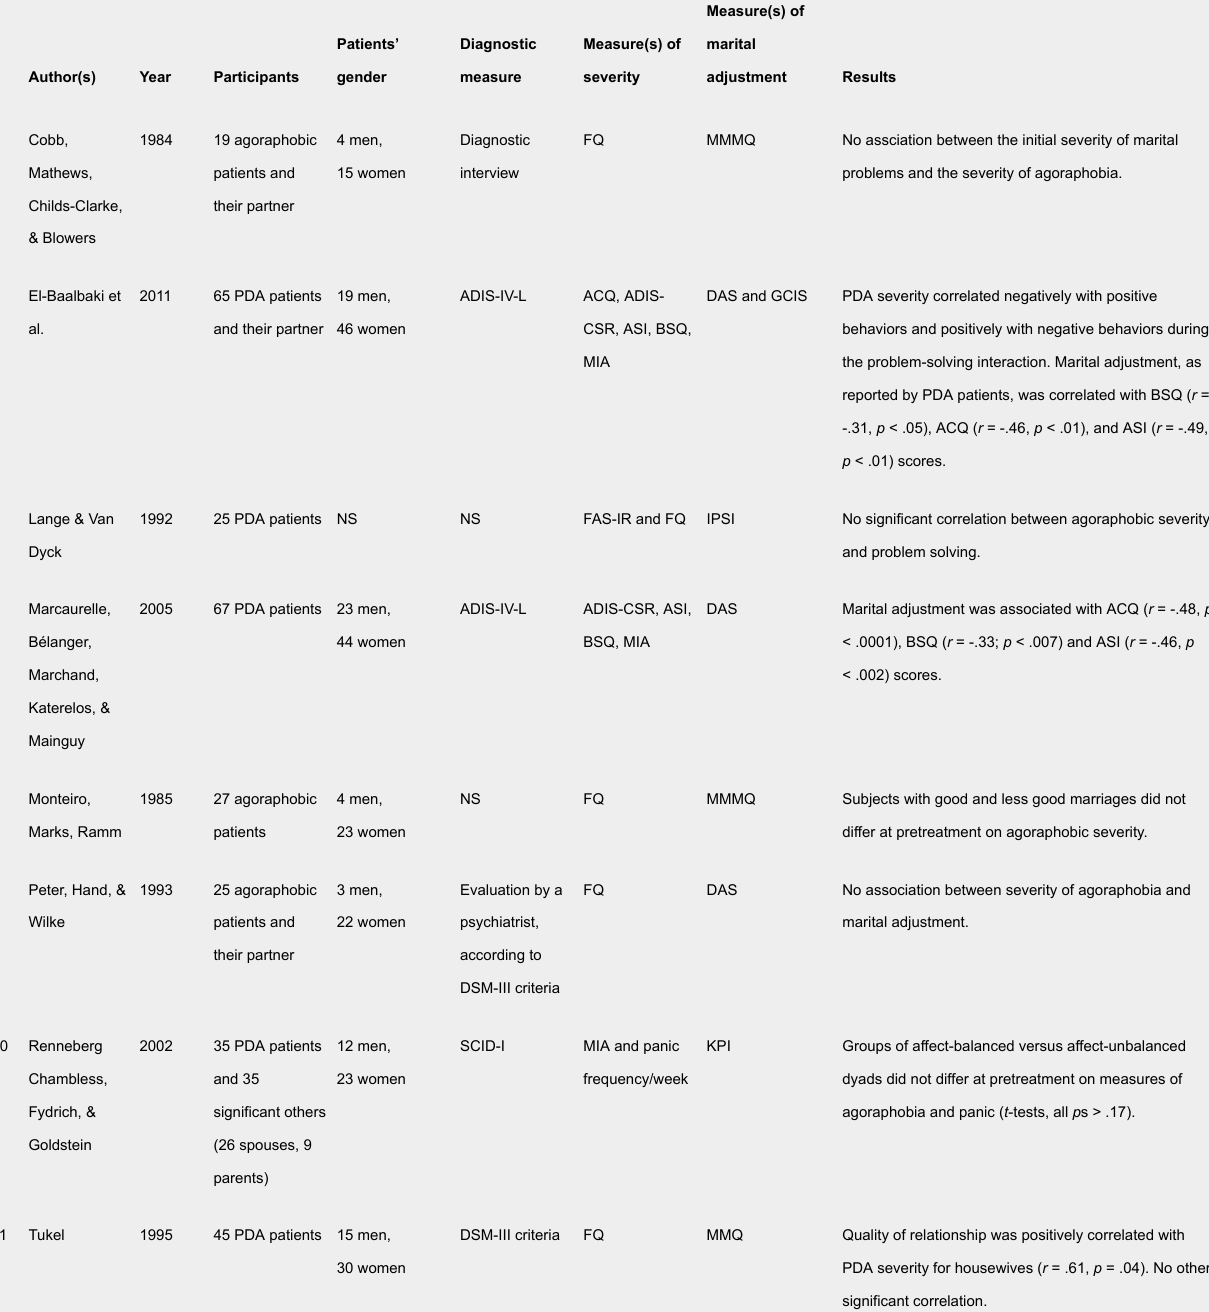
MMQ Quality of relationship was positively correlated with PDA severity for housewives ( r = .61, p = .04). No other significant